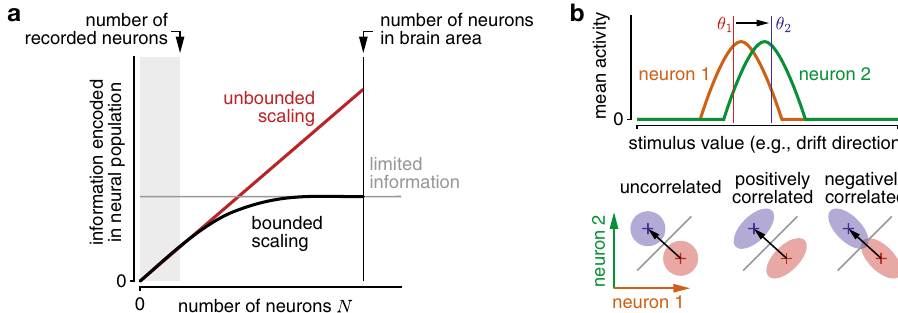
Fig. 1 Information scaling in large neural populations, and the impact of noise correlations on information. a The information that a population of neurons can encode about some stimulus value is always a non-decreasing function of the population size. Information might on average increase with every added neuron (unbounded scaling; red) if the information is evenly distributed across all neurons. In contrast, information can rapidly saturate if information is redundant, and thus it is not strictly limited by population size, but by other factors. In general, it has only been possible to record from a very small subset of neurons of a particular area (gray shaded), from which it is hard to tell the difference between the two scenarios if the sampled population size is too small. b The encoded information is modulated by noise correlations. This is illustrated using two neurons with different tunings to the stimulus value (top). The amount of information to discriminate between two stimulus values ( θ 1 /red and θ 2 /blue) depends on the difference in mean population activity (crosses) between stimuli, and the noise correlations (shaded ellipsoids) for either stimulus (bottom, showing joint neural activity of both neurons). The information is largest when the noise is smallest in the direction of the mean population activity difference (black arrow), which leads to the largest separation across the optimal discrimination boundary (gray line). In this example, positive correlations boost information (middle), whereas negative correlations lower it (right), when compared to uncorrelated neurons (left). In general, the impact of noise correlations depends on how they interact with the population ’ s tuning